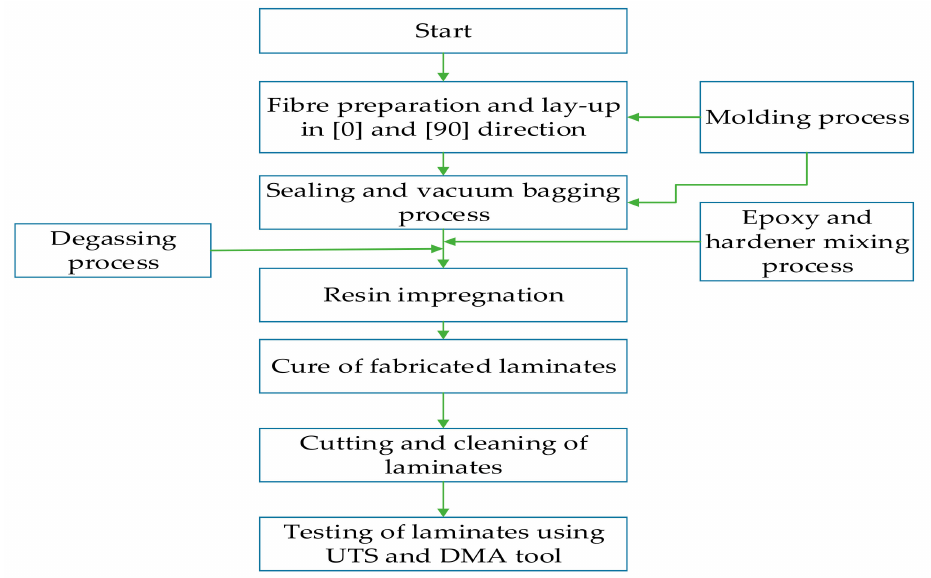
Figure 1. Process flowchart used in the manufacturing and testing of laminates using the RTM process.